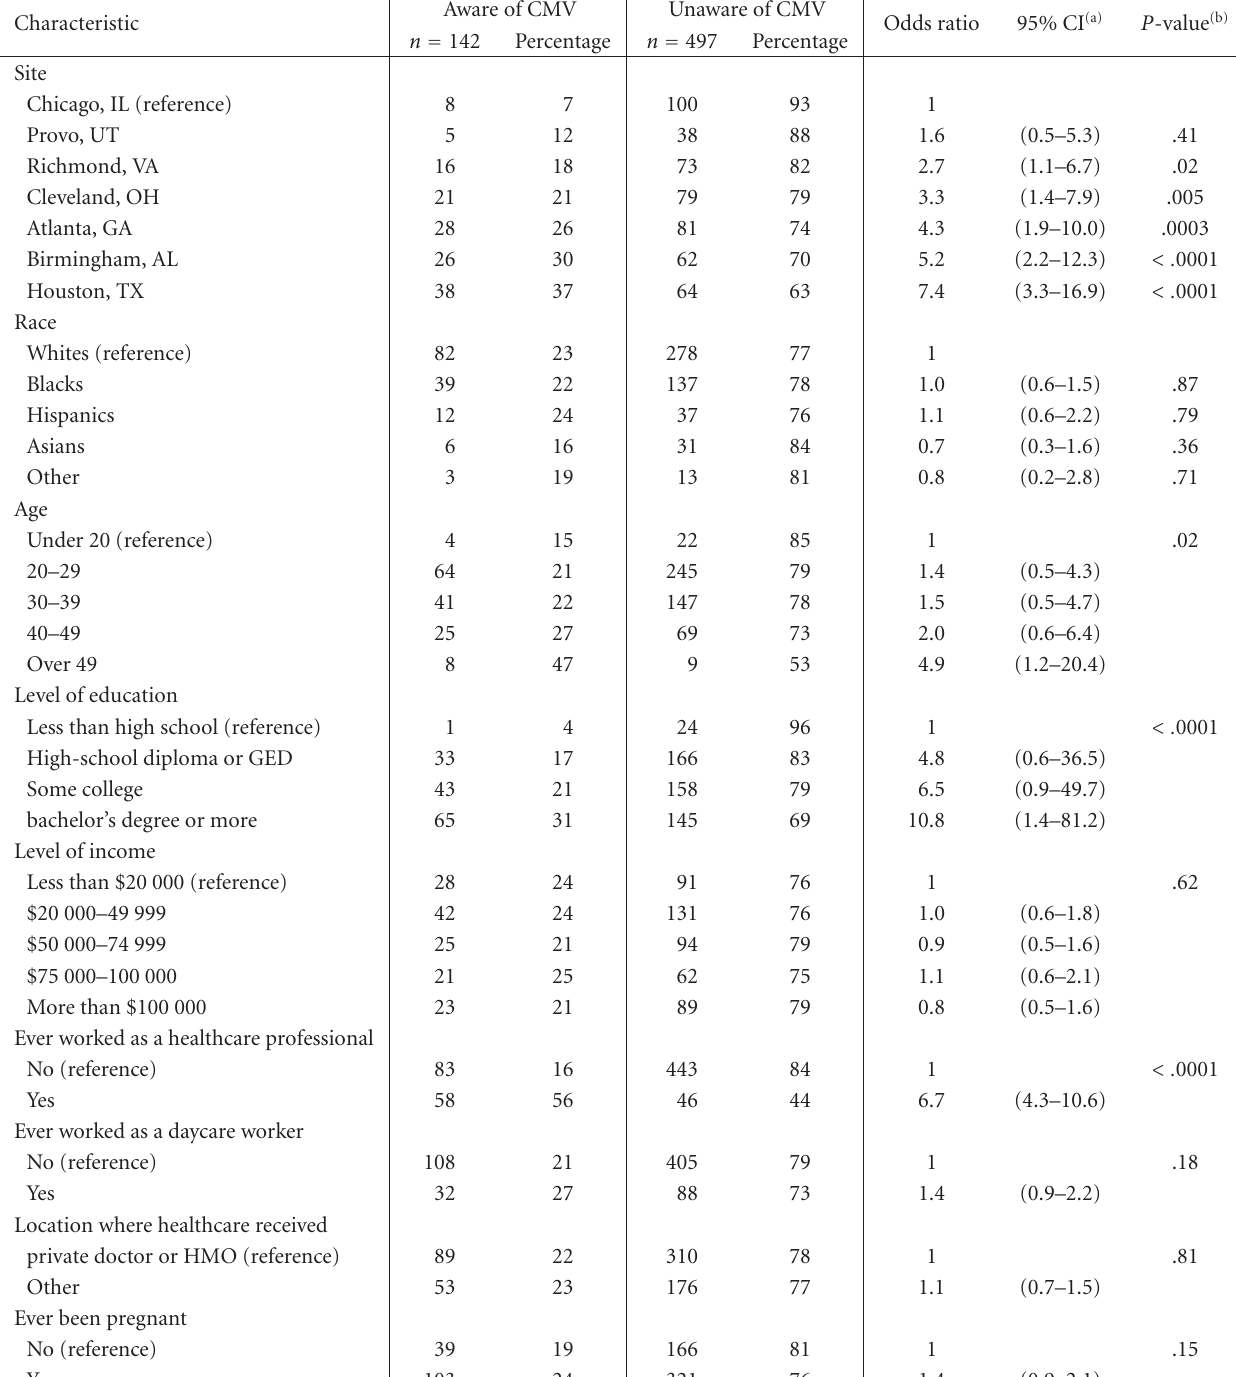
Table 1: Awareness of congenital CMV by characteristics of women. Note that not all questions had responses from all participants.